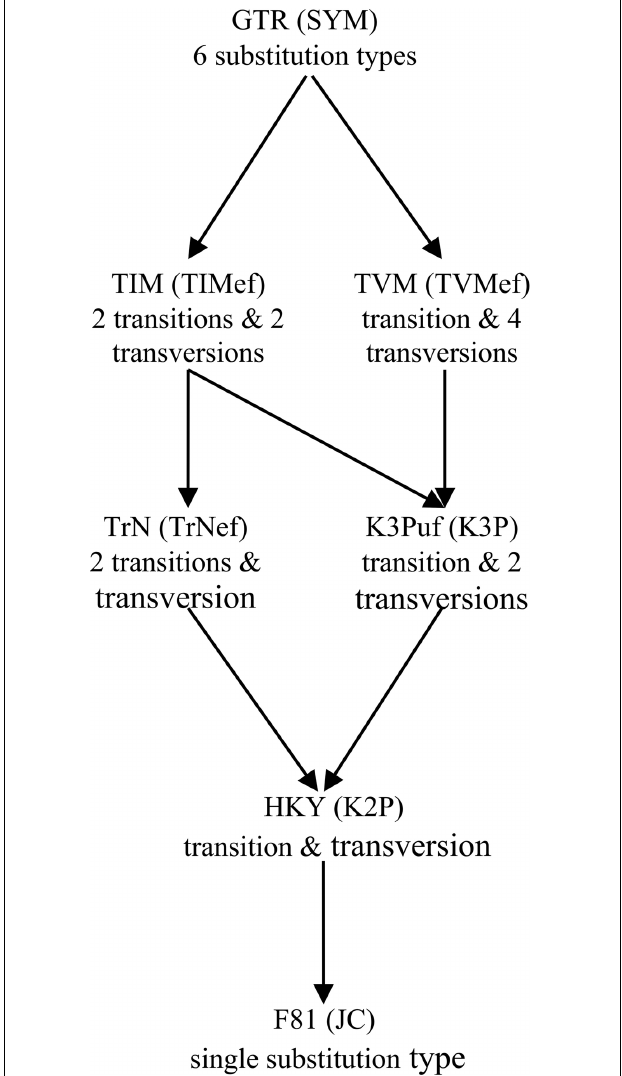
FIGURE 1 | Relationship among 14 homogenous time-reversible models of nucleotide substitution. Arrows indicate parameter restrictions that reduce a more general, higher-parameterized model to a more restricted, lower-parameterized one. For each case of distinct substitution types corresponding to a pair of models, the model outside the brackets allows unequal equilibrium base frequencies and the model inside the brackets assumes equal equilibrium base frequencies. These models are: JC (Jukes and Cantor, 1969), which is equivalent to the s- state Poisson model for nucleotides ( s = 4); K2P (Kimura 2-Parameter, a.k.a. K80; Kimura, 1980); TrNef (Tamura and Nei, 1993 model with e qual base f requencies); K3P (Kimura 3-Parameter, a.k.a. K81; Kimura, 1981); TIMef (TransItional Model with e qual base f requencies); TVMef (TransVersional Model